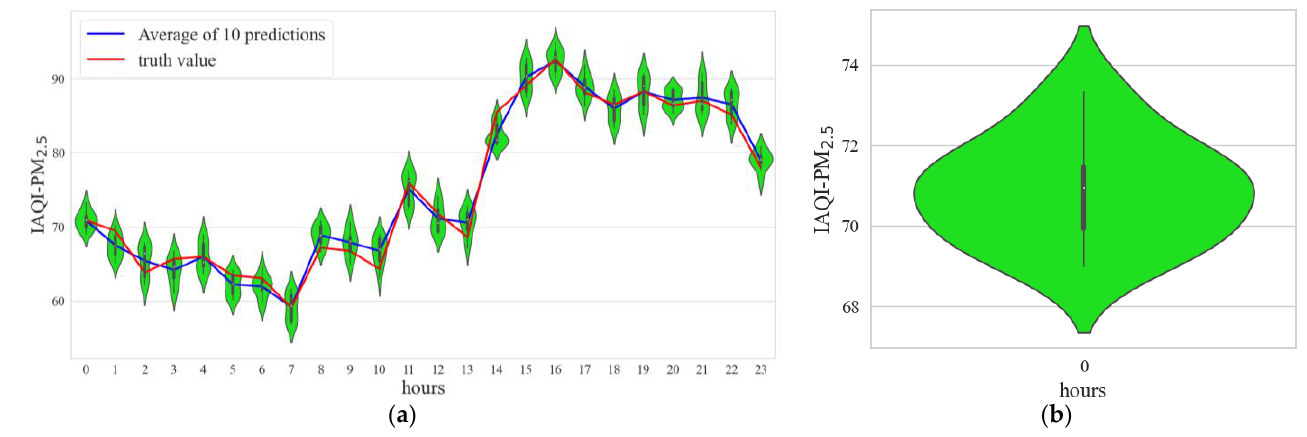
Figure 13. Violin figure of IAQI-PM 2.5 prediction. ( a ) 0 o’clock to 23 o’clock ( b ) 0 o’clock .